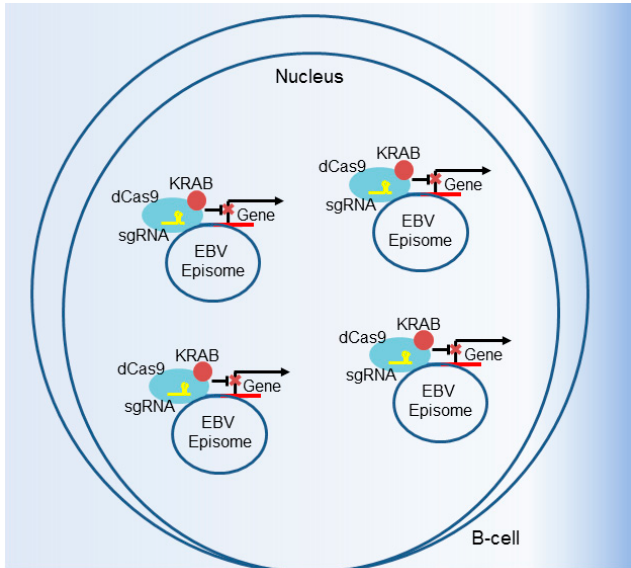
Figure 6. CRISPRi suppression of viral gene expression. CRISPRi can be used to target viral genomes, including multicopy EBV episomes. In this schematic, a sgRNA targets the dCas9–KRAB fusion